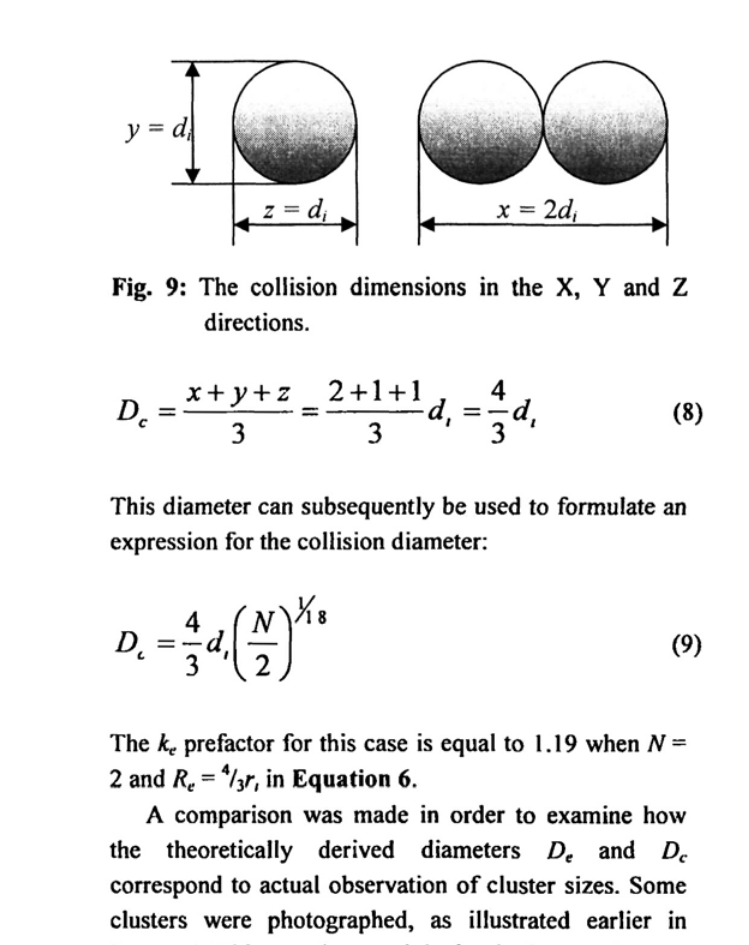
Fig. 9: The collision dimensions in the Χ, Υ and Ζ directions.